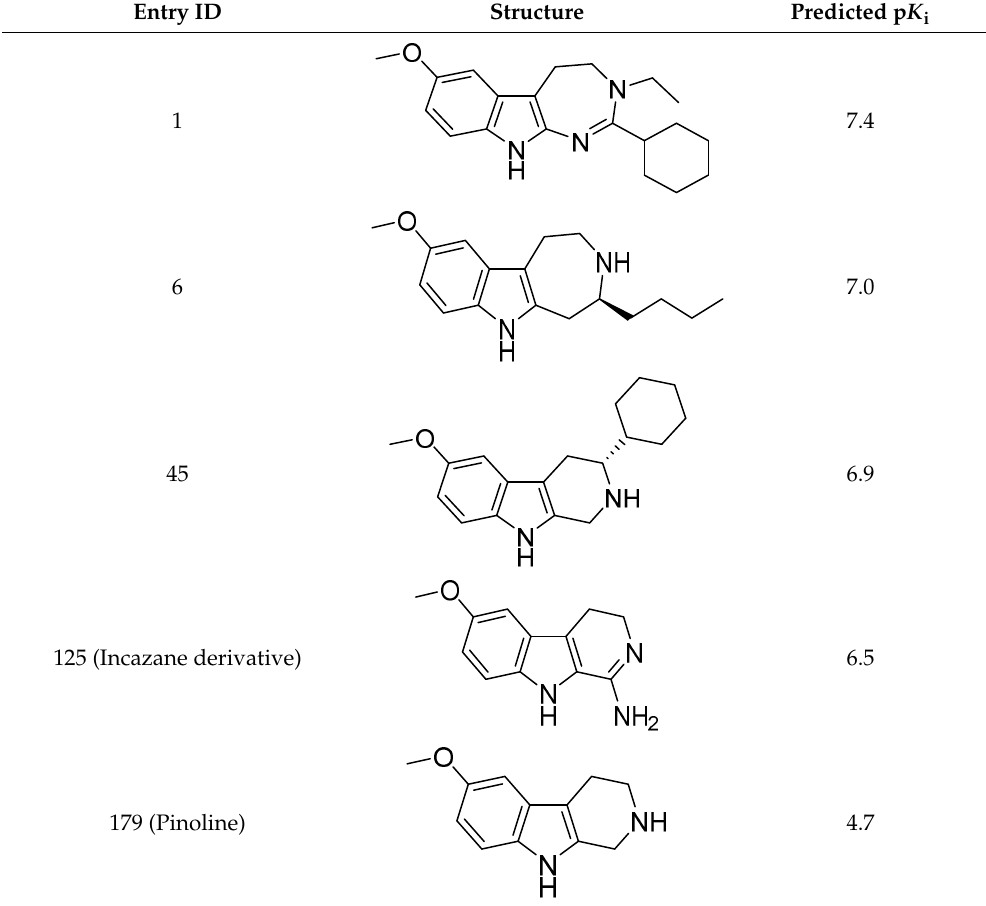
Figure 2. Structure of incazane. Table 1. Structure and predicted p K i values of the selected ibogaine derivatives resulted from the scaffold-hopping study of Series 1.